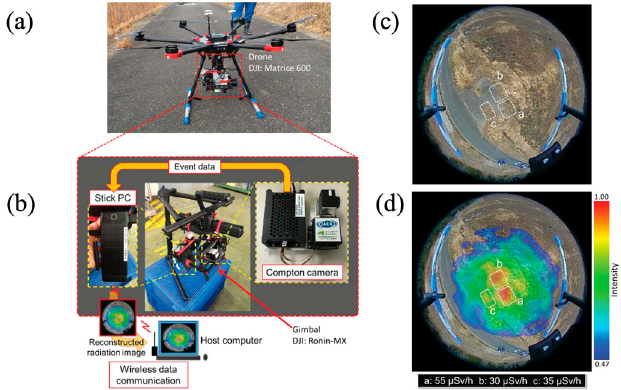
Figure 13. ( a ) Drone used for carrying Compton camera for radiation monitoring. ( b ) Zoomed view of radiation measurement system. ( c ) Optical image taken using drone at altitude of 6 m. ( d ) Radiation image measured using the drone system in which the a, b, and c regions represent the hotspots [181]. Reproduced with permissions from Sato et al. [181].